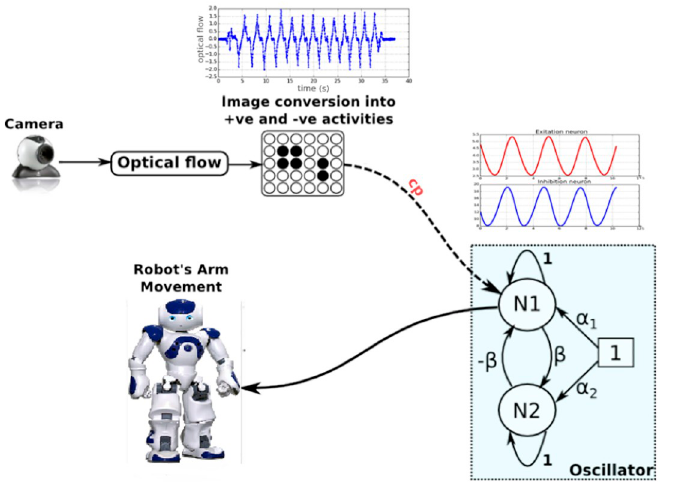
Fig 2. The robot’s sensorimotor